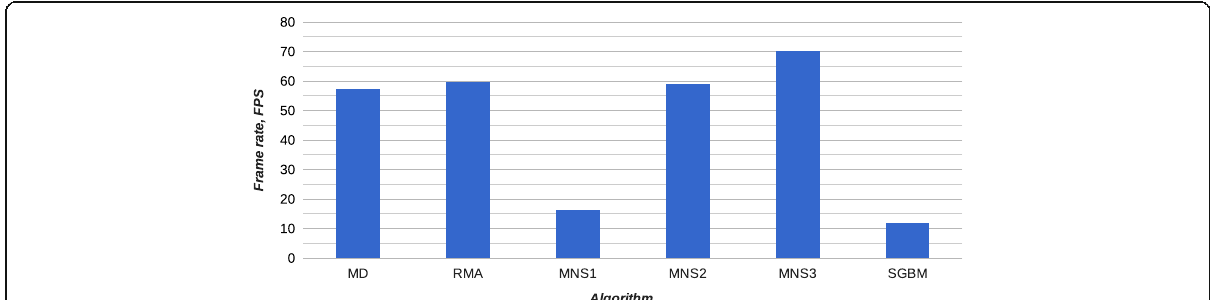
Fig. 6 The average frame rate of all training images. Evaluated on the Q resolution training set using Jetson